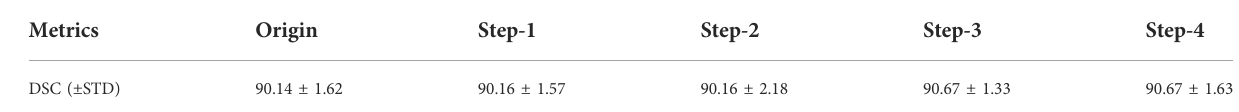
TABLE 2 Post-processing performance (%).